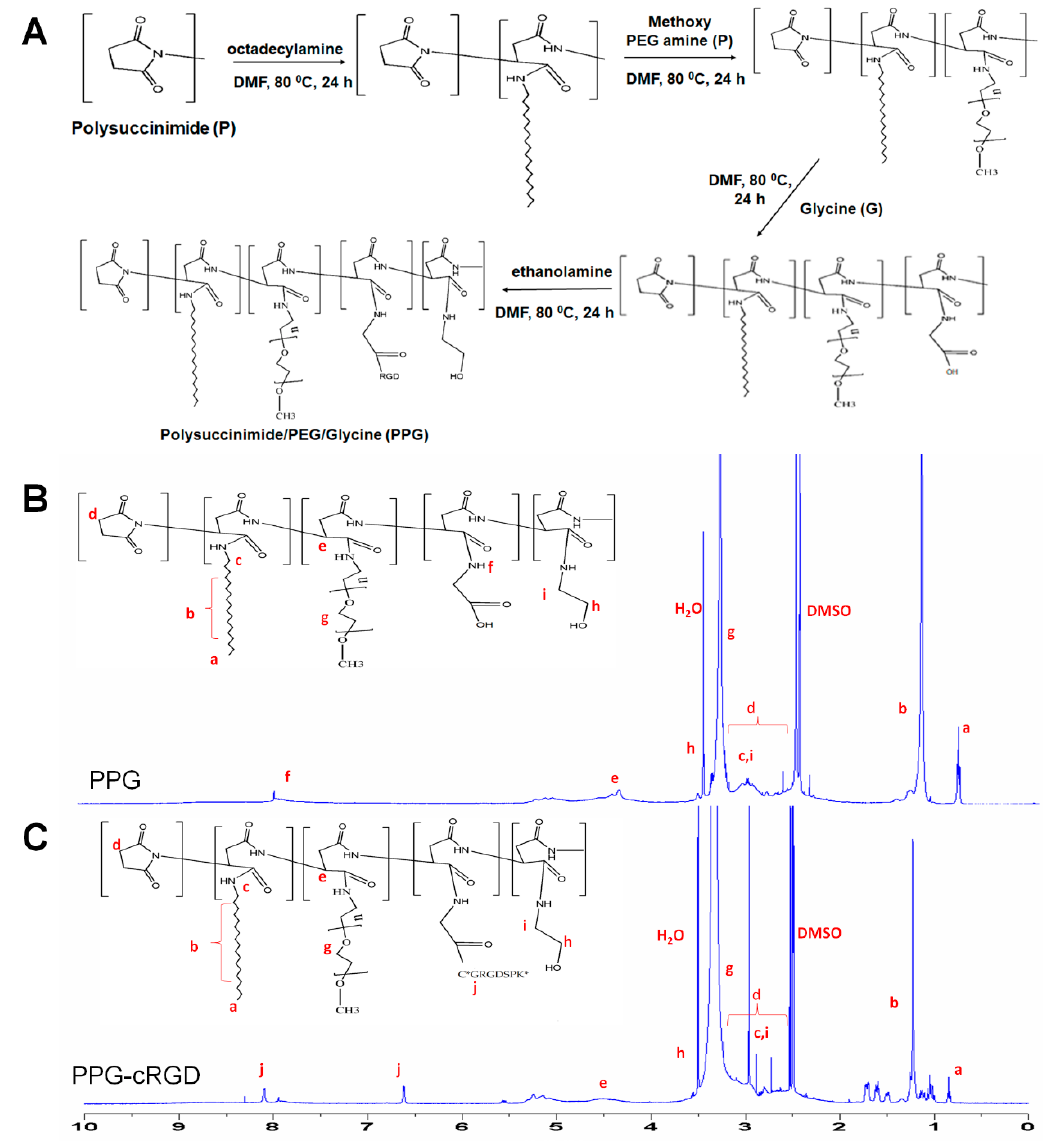
Figure 2. ( A ) Overall reaction scheme of PHEA conjugated with octadecylamine, methoxy PEG amine, and glycine. 1 H NMR analyses of PPG NPs ( B ) and PPG-cRGD NPs (C).